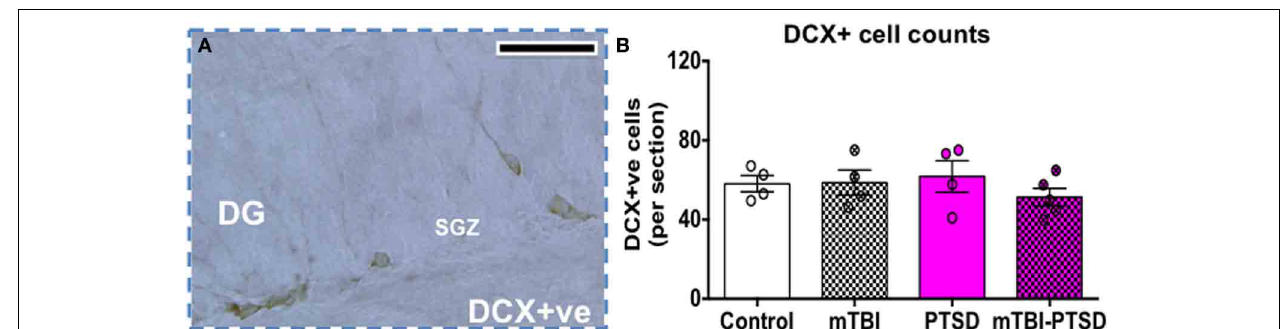
FIGURE 7 | Global brain-related changes observed at acute post-mTBI-PTSD time-point. Hallmark potential biomarkers of mTBI (in humans) were analyzed in brain hemispheres. Western blot analysis showed a significant increase in axonal marker, neurofilament L (NFL) and inflammatory marker CD54 (ICAM)-1 levels in mTBI-PTSD groups compared to control ( P = 0.022 and P = 0.016 respectively— A,C ). No statistically significant changes were observed in astrocyte cytoskeletal protein—GFAP